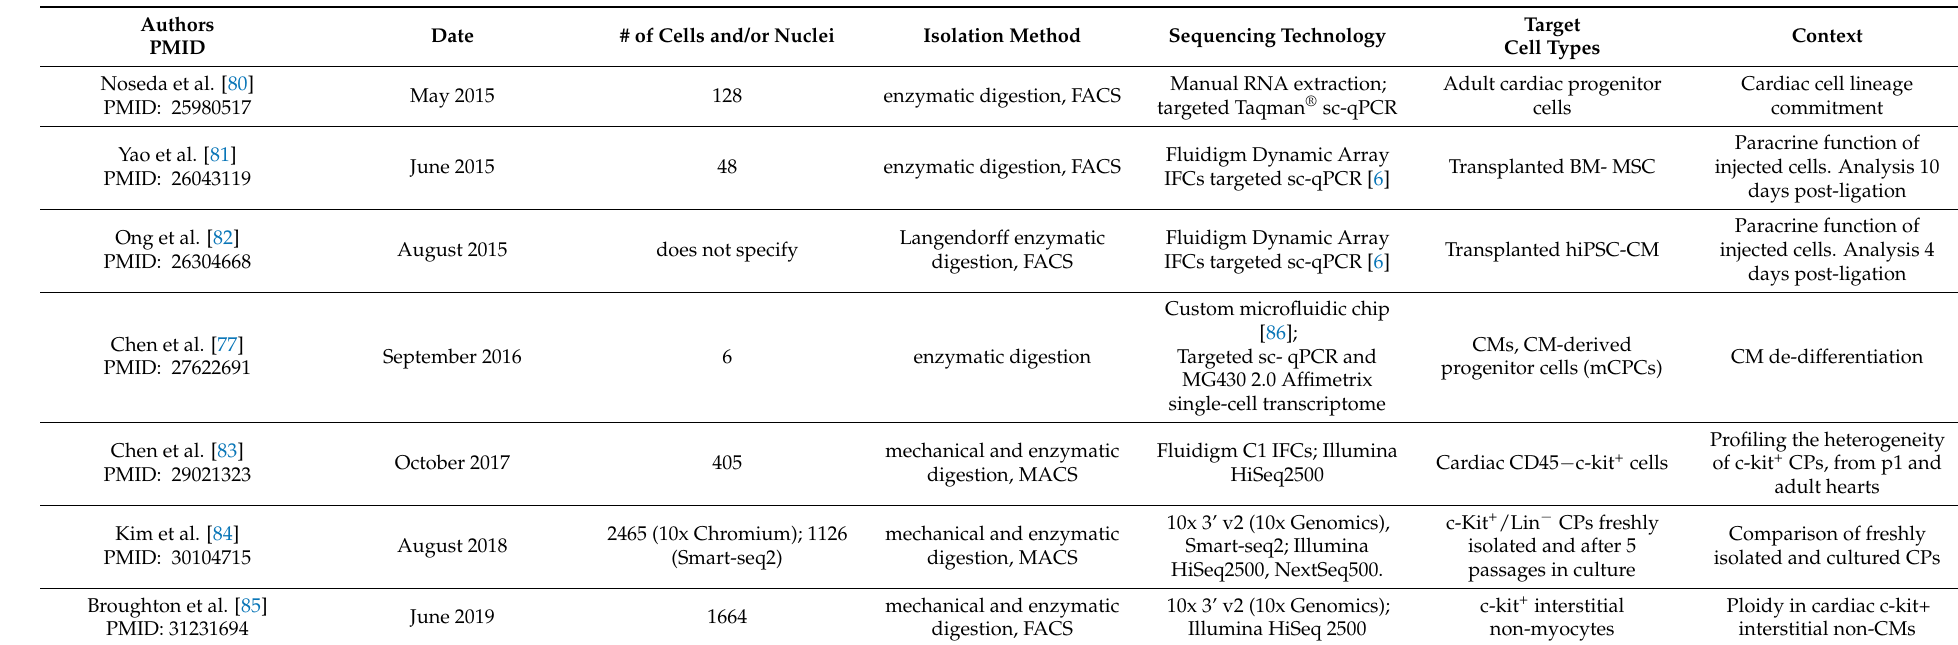
Table 3. Adult Cardiac Progenitor